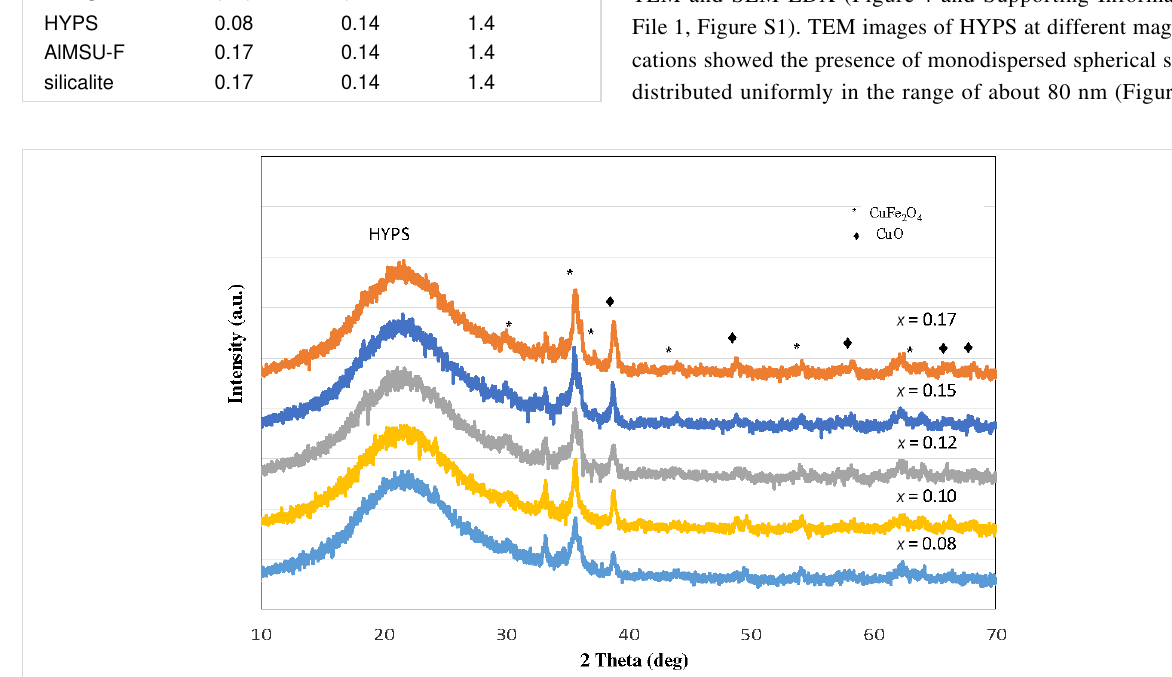
Figure 1: Powder XRD patterns of CuFe 2 O 4 /HYPS with different Cu concentrations ( x = 0.08, 0.10, 0.12, 0.15 and 0.17).